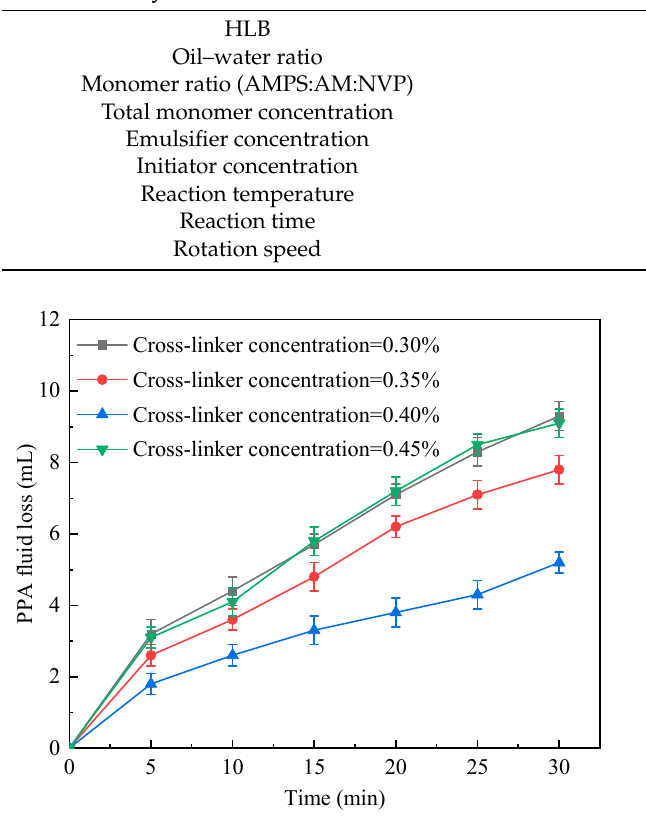
Figure 5. PPA fluid loss vs. time in cases of different cross-linker concentrations.